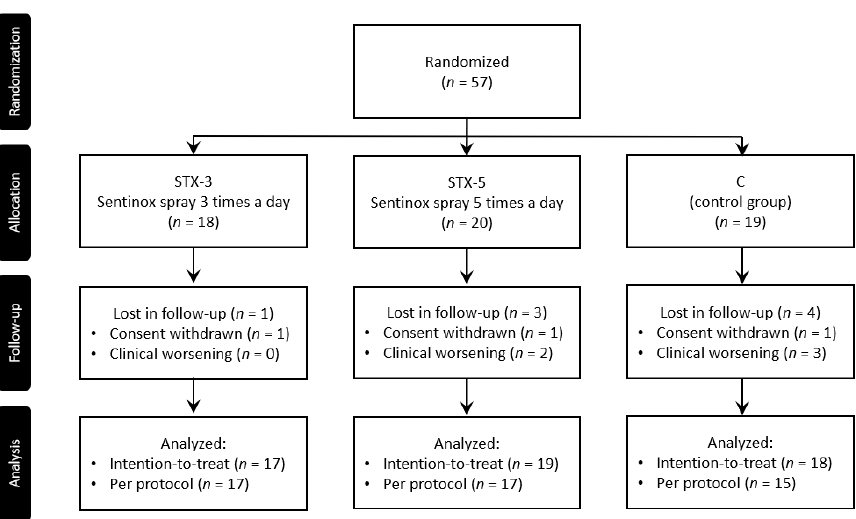
Figure 1. Flow chart of participants through the study.